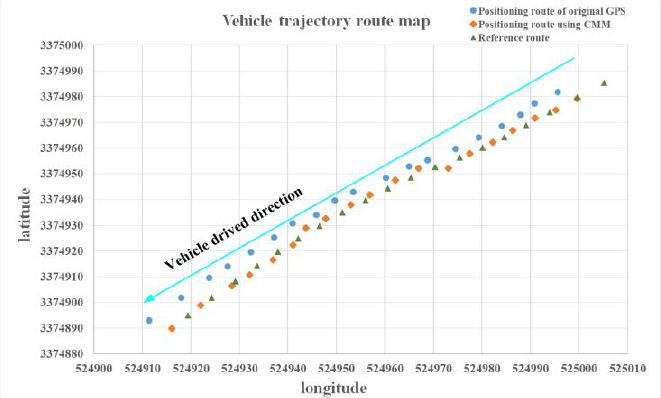
Figure 11. 101 – 119 s time period vehicle positioning trajectory route map. Figure 11. 101–119 s time period vehicle positioning trajectory route map. Table 5. The MAE and RMSE of dynamic positioning experimental